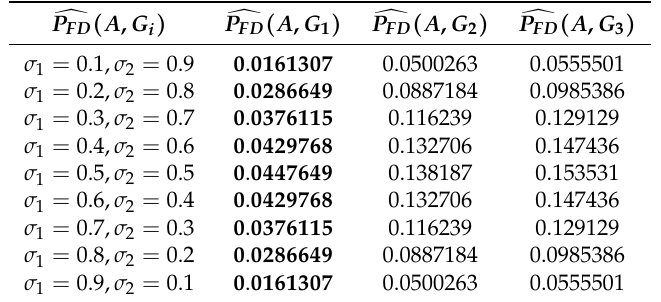
Table 2. Pattern Recognition Results for Picture Fuzzy Divergence